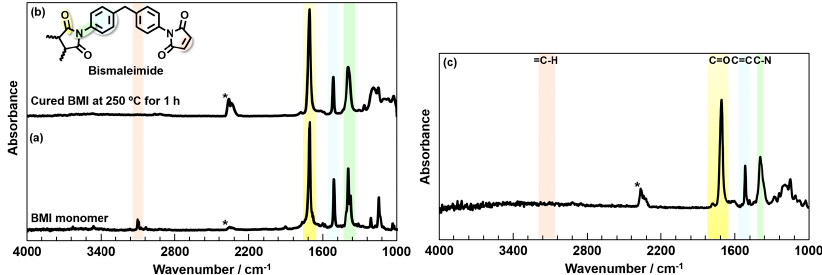
Figure 2. ATR-FT-IR spectra of ( a ) BMI monomer; ( b ) cured BMI resin; and ( c )